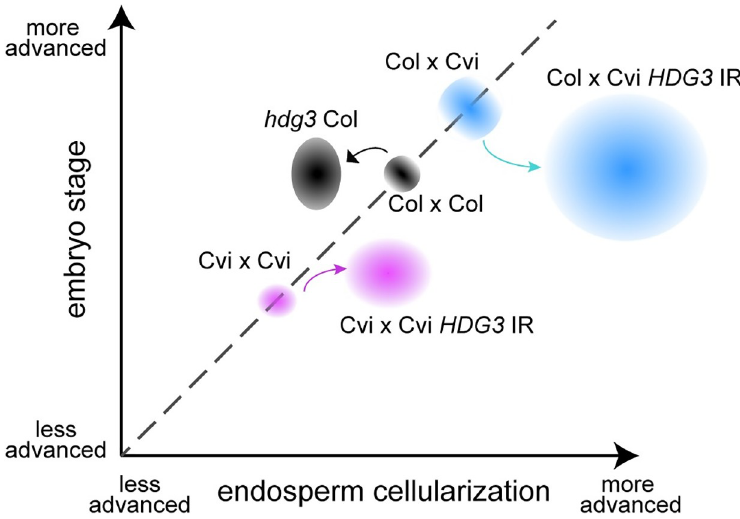
Fig 7. Schematic summary of relative seed development at 5 DAP. Shapes represent phenotypic space occupied by the indicated genotypes.